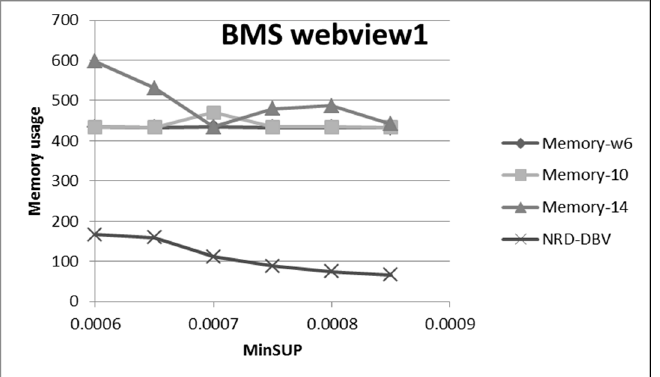
Figure 6. Comparison of memory usage for the TRuleGrowth with the NRD-DBV algorithm for (BMS webview1) dataset.